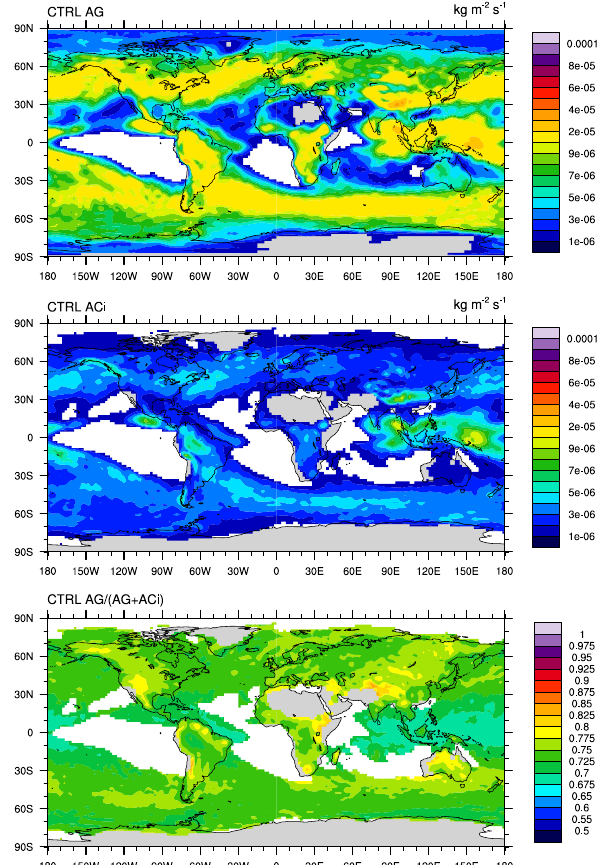
Figure 10. Mean vertically integrated aggregation (AG) and (ice) accretion rates (ACi) of CTRL for the year 2000, such as the fraction of AG to the total collection rate (AG +